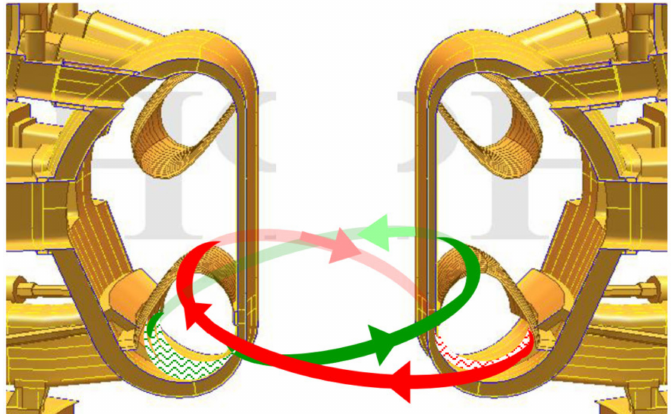
Figure 1. EM model of the perfectly anti-symmetric halo current component has at least a pair of identical helical bridges (shown here by red and green arrows) equally spaced in toroidal direction (by 180 degrees for each pair) and carrying always equal by modulus but opposite currents. Yellow poloidal bridges and all conductive structures are parts of rather standard FE model [4] for VDE